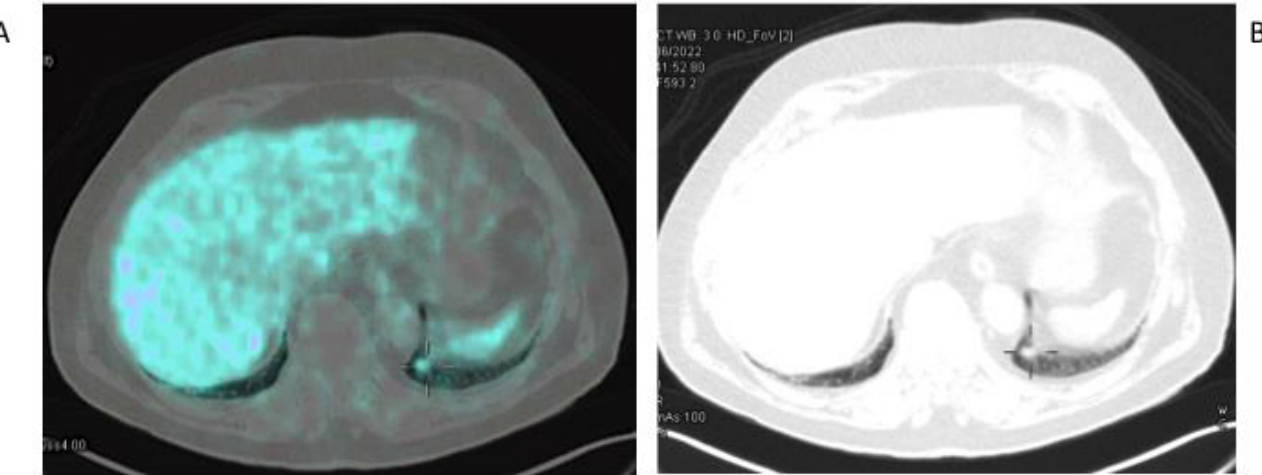
Figure 3. Incidental finding of primary lung cancer in a 72-year-old patient studied with 68 Ga- PSMA-11 for prostate cancer; the PSA levels at the time of the study were 0.005 ng/mL. A fused PET/CT image ( A ) showing mild 68 Ga-PSMA uptake in the posterior basal segment of the left lung corresponding to a small lung nodule from a co-registered low-dose CT scan ( B ). Histology showed a primary lung